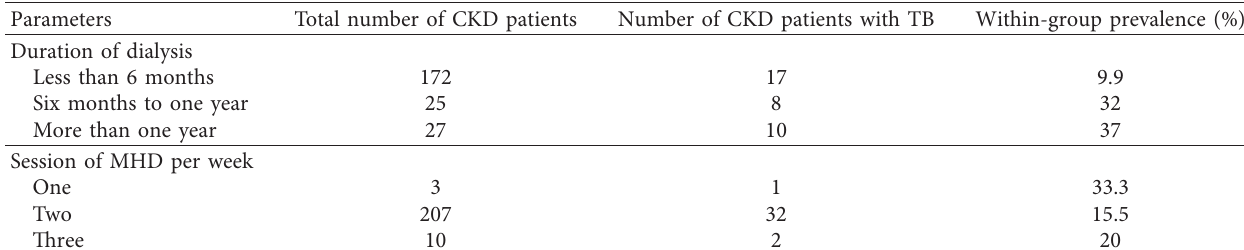
Table 2: Prevalence of TB in different